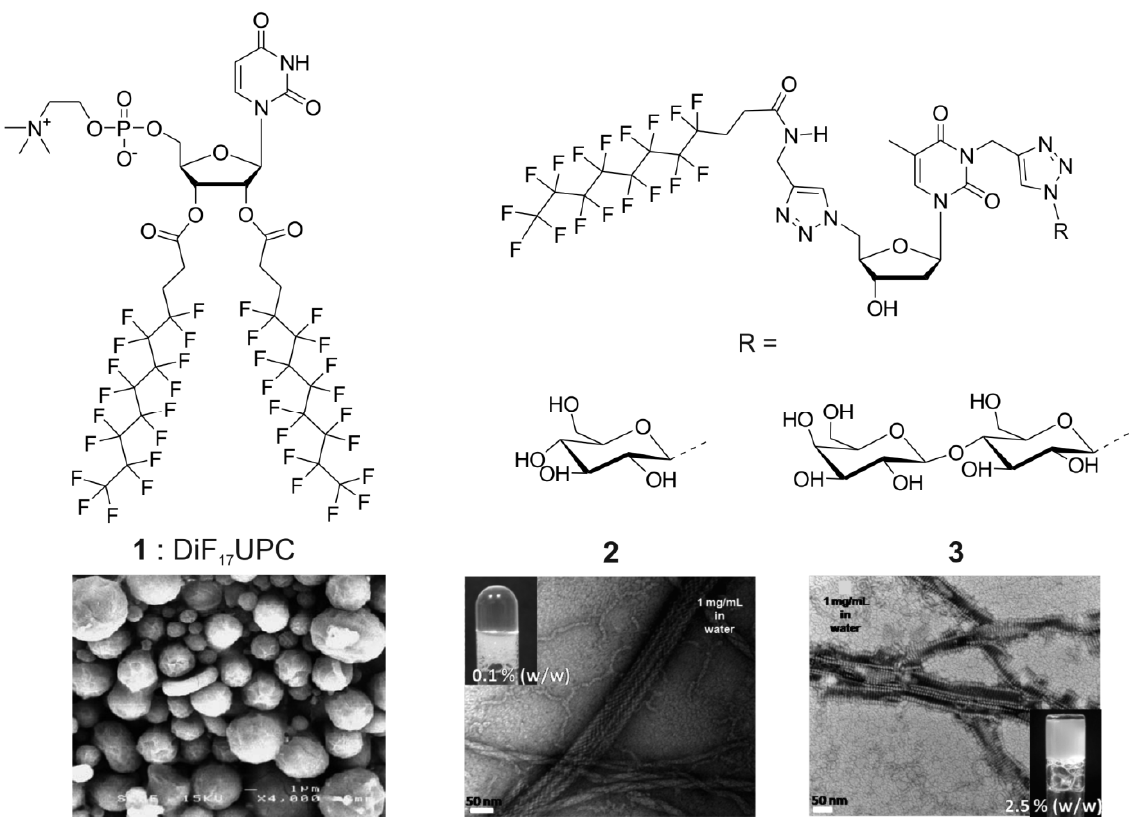
Figure 4. Chemical structures of compounds 1-3 , and corresponding electronic microscopy images of DiF UPC/Th 4+ microspheres (SEM image from [55]), and supramolecular 17 assemblies formed by GNFs 2 and 3 in water (TEM images from